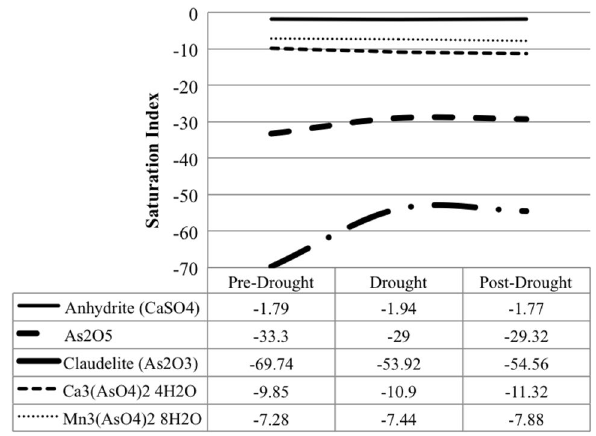
Fig. 4 Evolution of saturation index model of arsenic species in high concentration